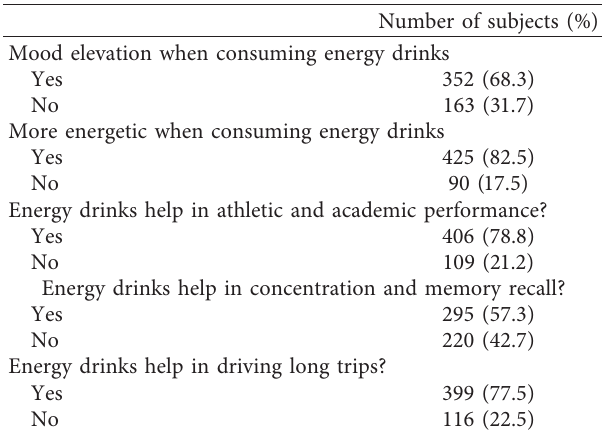
Table 4: The perceived desirable effects of energy drink among